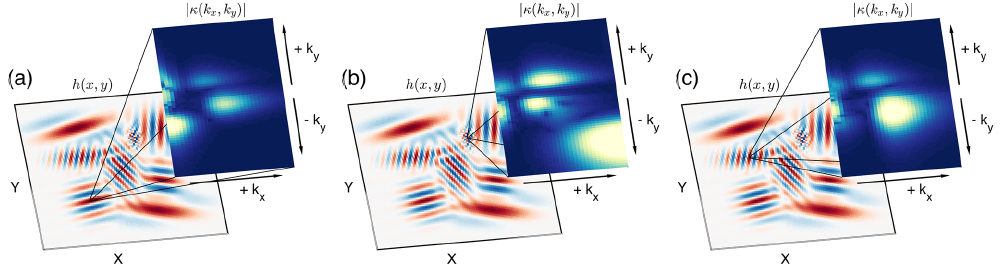
Figure 1. The specified wave field h(x,y) (background) for which the two-dimensional Stockwell transform (2DST) has been computed. The absolute magnitudes of the localised 2DST wavenumber spectra | κ(k x ,k y ) | (foreground) are plotted for three separate locations in (a) , (b) and (c)